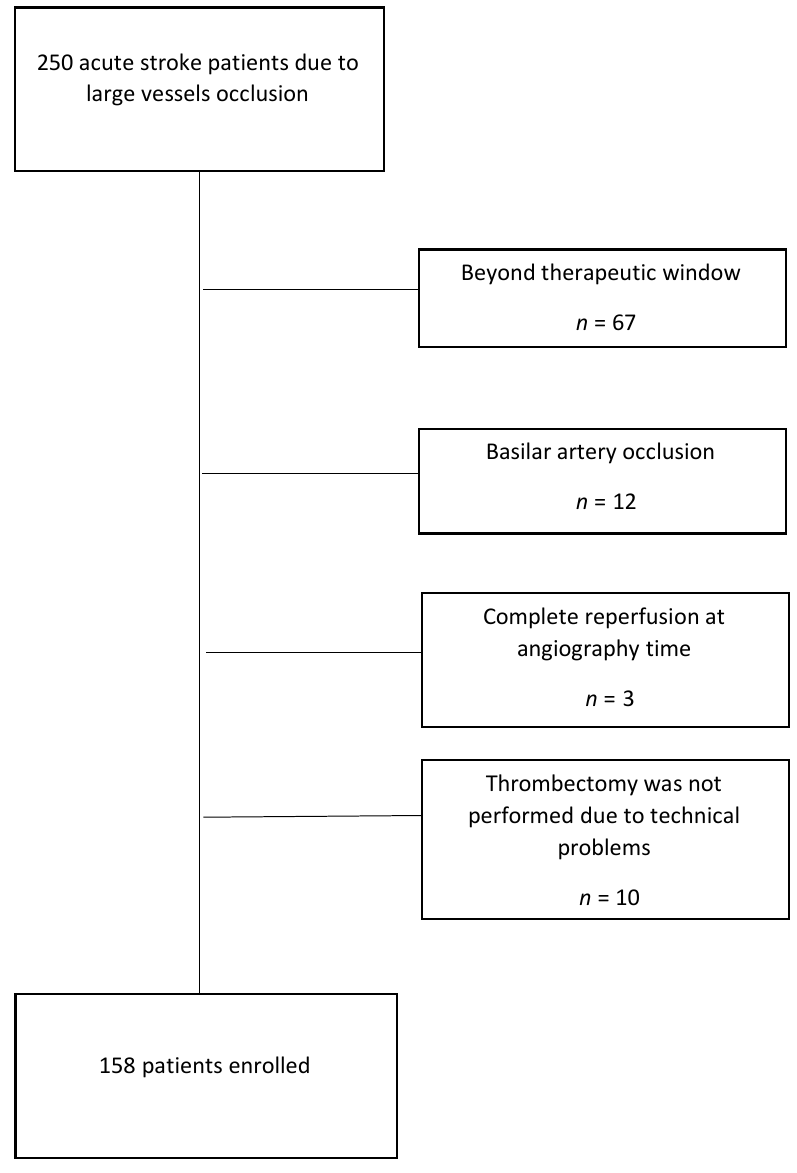
Figure 1. Flowchart of patients’